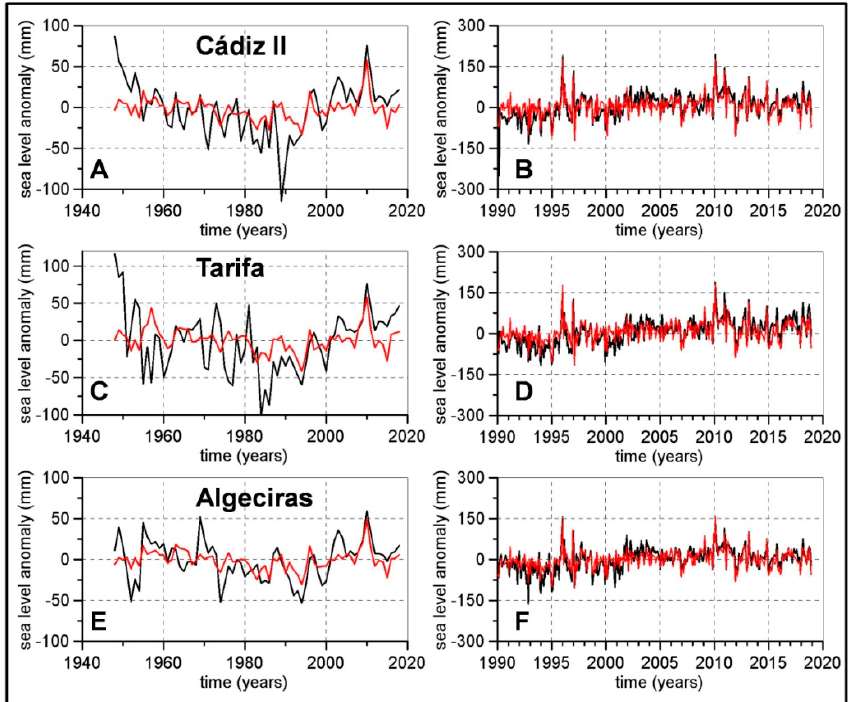
Figure 6. Observed sea level anomalies and regression from the linear model. Black lines are the observed sea level (de-seasoned and de-trended) at Cádiz, Tarifa, and Algeciras. Red lines are the values predicted by a linear model based on the atmospheric variables and the thermosteric and halosteric components of sea level (see the text and Table 4). ( A , C , E ) show annual mean values for the period 1948–2018. ( B , D , F ) show monthly values for the period 1990–2018.